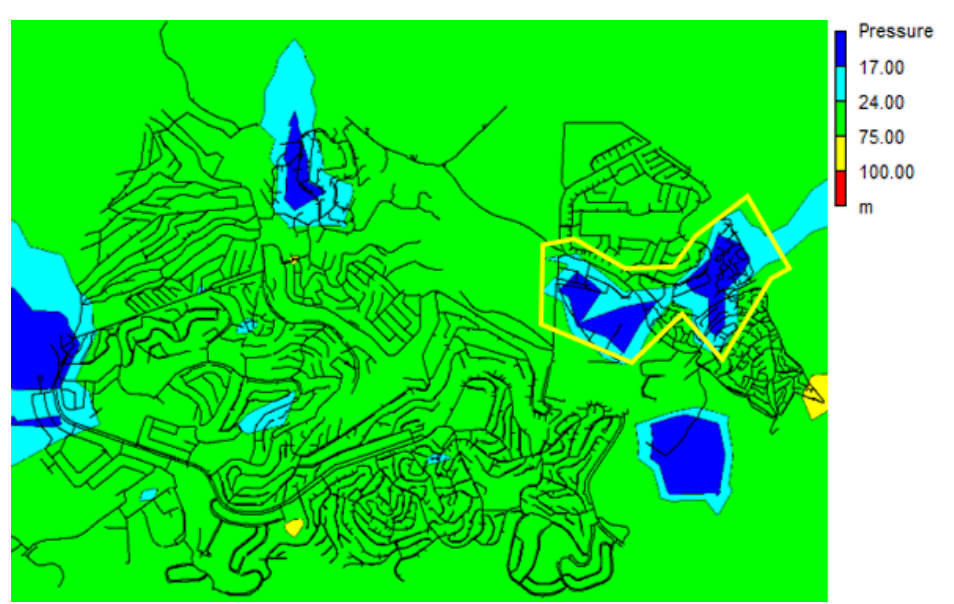
Figure 5. Pressure head critical zones due to